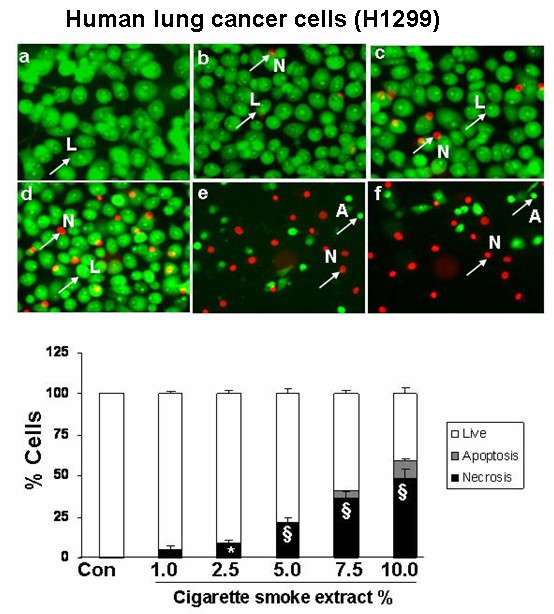
Cigarette smoke extract caused necrosis with no or little evidence of apoptosis in human lung cancer cells (H1299). Human lung cancer cells (H1299) were treated with media alone (control) and various concentrations of CSE; a) control, b) CSE (1.0%), c) CSE (2.5%), d) CSE (5.0%), e) CSE (7.5%), f) CSE (10%) for 24 hr. The cells were stained with ethidium bromide and acridine orange and observed under fluorescence microscopy. Living cells had normal shaped nuclei with green chromatin. Early apoptotic cells have shrunken green nuclei with chromatin condensation, whereas necrotic or late apoptotic cells had normal/condensed nuclei that were brightly stained with ethidium bromide and appeared red. Percentage of viable (white bars), apoptotic (grey bars) and necrotic/late apoptotic (black bars) determined by counting as described in Materials and Methods. Results are mean of 3 experiments ± SEM. *p < 0.05, and §p < 0.001 compared with control group. L = Live; A = Apoptosis; N = Necrosis.